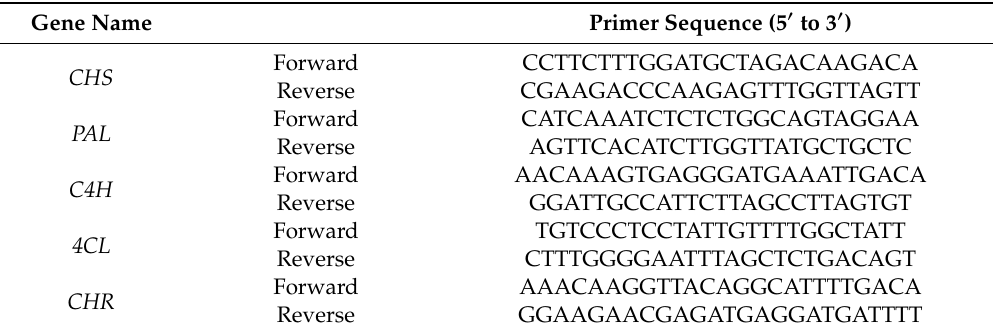
Table 1. Primer sequences for polymerase chain reaction